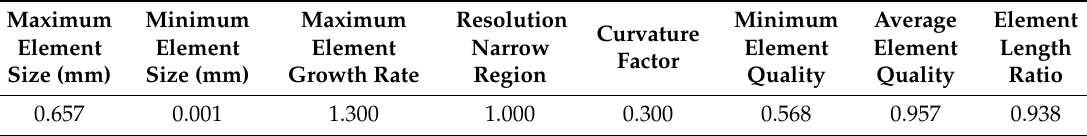
Figure 4. Grid independent analysis at 150 kW / m 2 radiation heat flux, 1 atm and 1.8 L / h gas laminar inflow rate: ( a ) Cross-sectional view of mesh; ( b ) Temperature distribution along the axial length; and ( c ) Temperature distribution with di ff erent cell number. Table 2. Mesh characteristics user-controlled